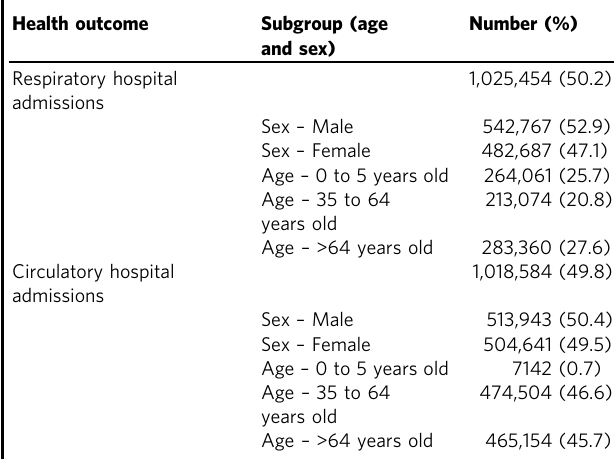
Table 1 Descriptive characteristics of hospital